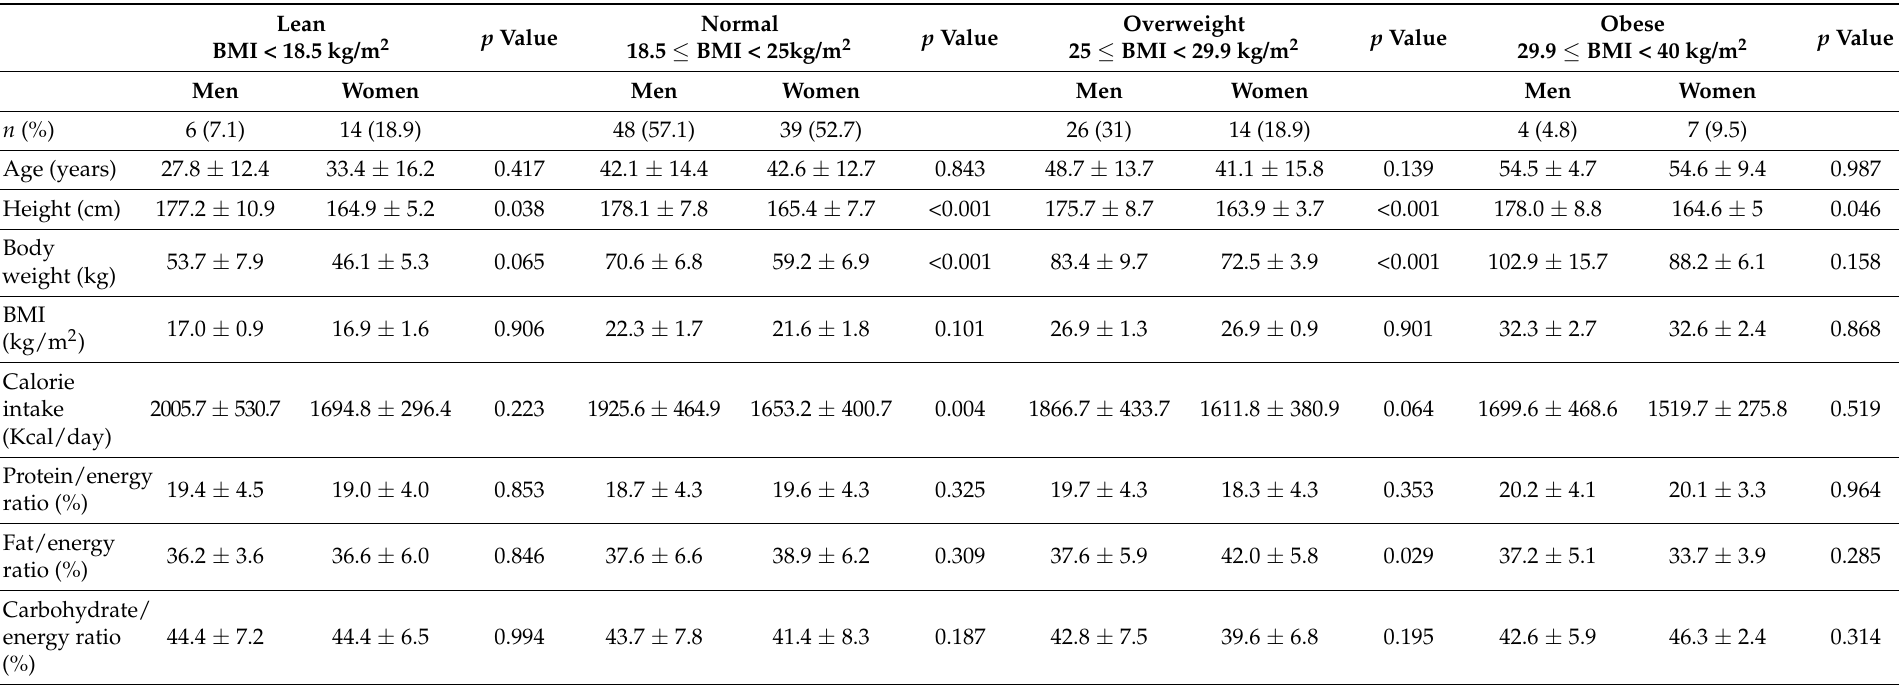
Table 4. Mean intake of energy and nutrients according to the body mass index of men and women with